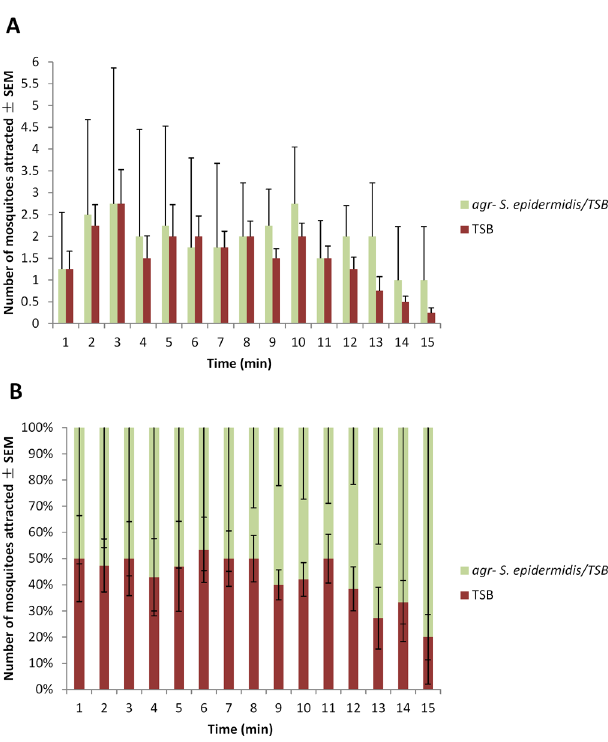
Fig 4. Mean number (A) and (B) percent of 5-8-d-old adult female Ae . aegypti mosquito attraction per minute ± SEM to blood-feeders treated with TSB or agr- S . epidermidis /TSB located on the right and left sides of the top of a 82 cm x 45 cm x 52 cm Plexiglas cage during 15-min trials (N 1 = 4; n 2 = 50) at approximately 25°C and 80% RH. 1 number of trials conducted; 2 number of mosquitoes used in a